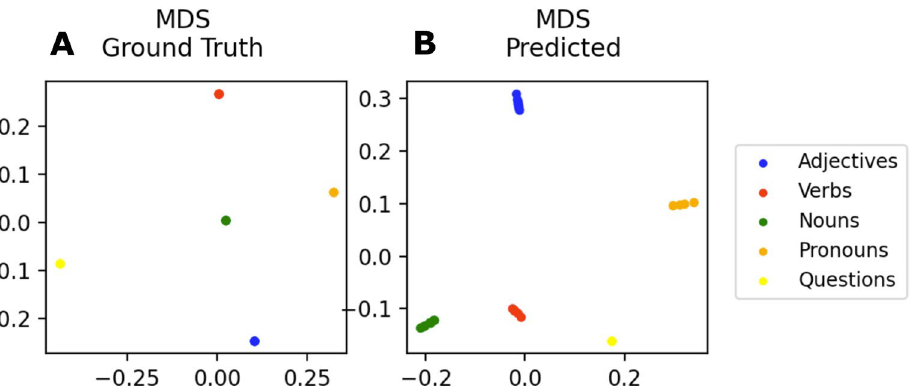
Figure 8. MDS of the word transition probability vectors: a two-dimensional projection of the 40-dimensional word TP vectors (rows in TP matrix) for the calculated ground truth ( A ) and the learned TP matrix ( B ). In both cases, the words build clearly separated, dense clusters according to the respective word class. Different colors correspond to word classes. Note that, scaling of the axes is in arbitrary units since coordinates have no particular meaning other than indicating the relative positions of the projected